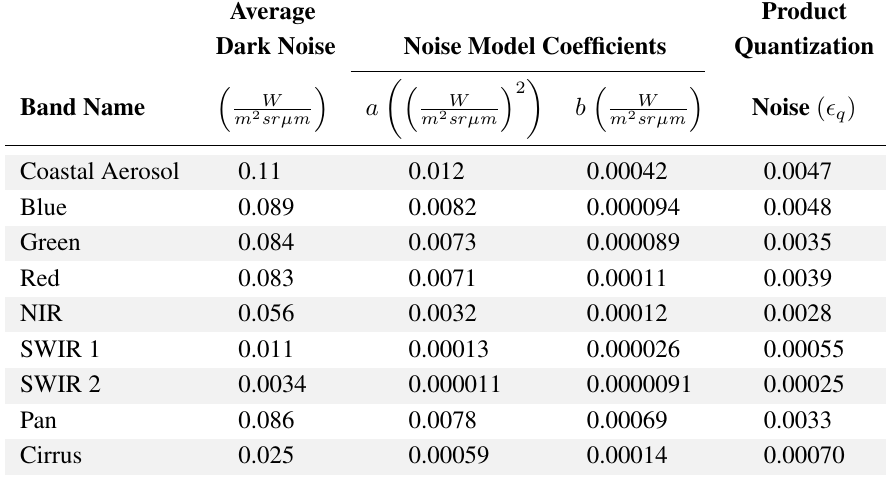
Table 3. Average total 1 σ noise and noise model coefficients for each spectral band at L . Typical